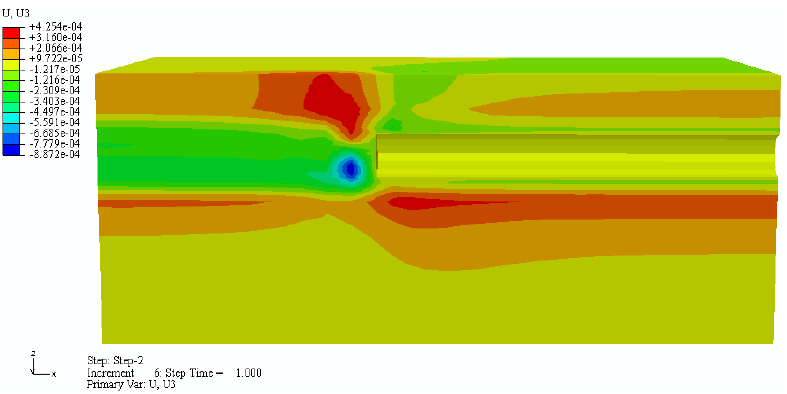
Figure 13. Vertical ground movement clouds of the model under additional thrust action (m).